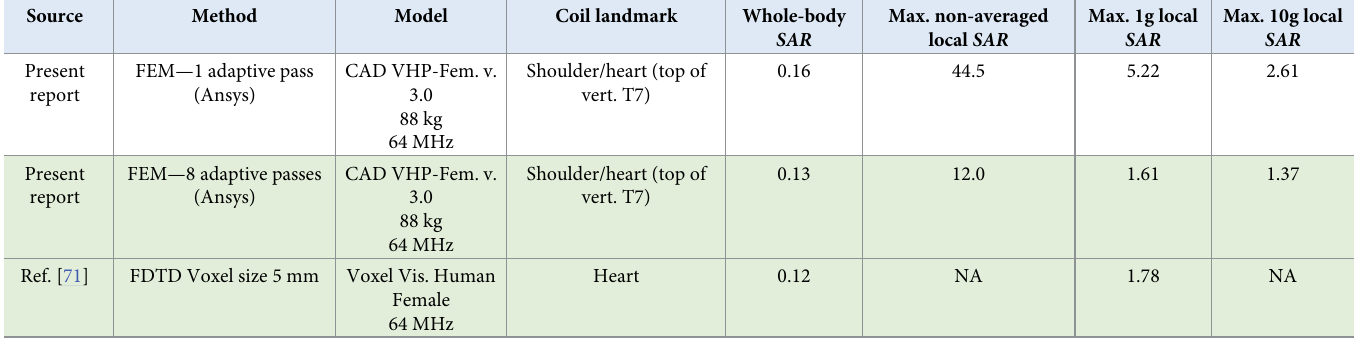
Table 1. Comparison of SAR values predicted using the VHP-Female surface CAD model with the values predicted by a 5 mm voxel model derived from the identi- cal image dataset [71]. Nearly identical high-pass birdcage coil dimensions, coil landmark, and excitation type were used. All results are normalized to 1 μ T B þ coil